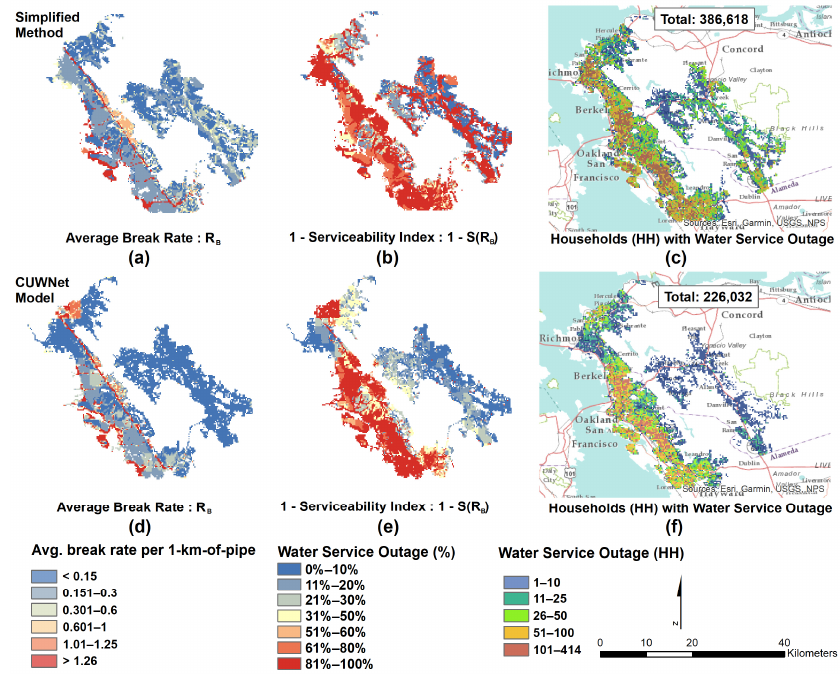
Figure 10. Comparison of simplified approach in EBMUD service area with CUWNet model [1] estimates: ( a ) Average break rates from simplified method; ( b ) water service outage (%) from simplified method; ( c ) water service outage (HH) from simplified method; ( d ) average break rates from CUWNet model [1]; ( e ) water service outage (%) calculation from CUWNet model [1] break rates; ( f ) water service outage (HH) calculation from CUWNet model [1] break rates.